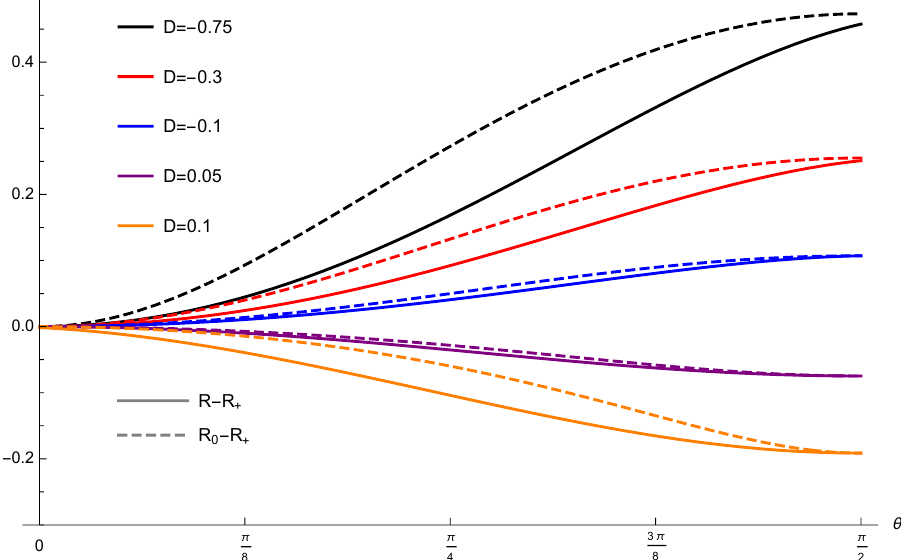
Figure 3 . Numerical integration of R − R + and R 0 − R + for a = 0 . 9 and varying D , respectively D = − 0 . 75 (black), D = − 0 . 3 (red), D = − 0 . 1 (blue), D = 0 . 05 (purple) and D = 0 . 1 (orange). The solution becomes unphysical when | D | becomes